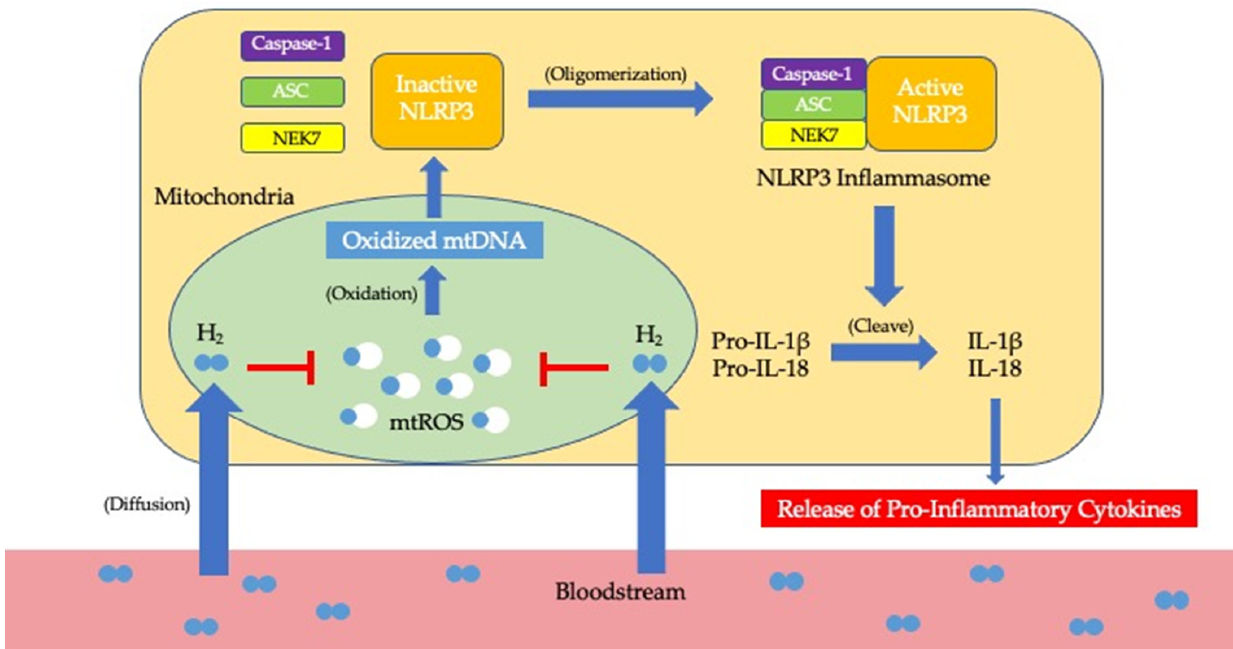
Figure 1. Suggested mechanism by which H 2 prevents the development of mibyou from chronic inflammation. H 2 travels around the body in the bloodstream and diffuses into mitochondria of various cells. By eliminating mtROS (e.g., ·OH) produced in mitochrondria, H 2 prevents the over-oxidation of mtDNA and, consequently, the over-activation of NLRP3. By inhibiting this cascade, H 2 controls the amount of pro-inflammatory cytokines released, leading to a control over chronic inflammation. H 2 : molecular hydrogen; mtROS: mitochondrial reactive oxygen species; mtDNA: mitrochondrial DNA; NLRP3: nucleotide-binding domain leucin-rich repeat and pyrin domain containing receptor 3; ASC: apoptosis associated speck-like protein containing a CARD; NEK7: NIMA-related kinase 7; IL-1 β : interleukin-1 β ; IL-18: interleukin-18.